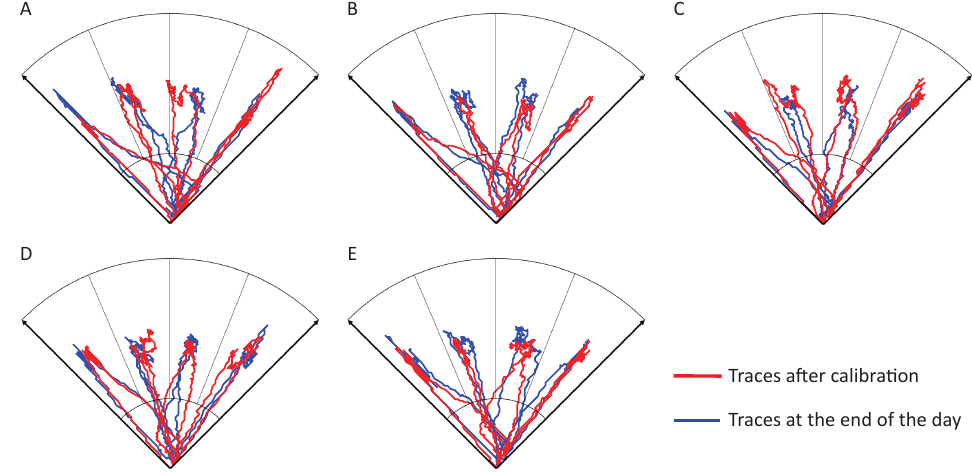
Figure 7. Representative cursor traces on ( A ) Day 1, ( B ) Day 2, ( C ) Day3, ( D ) Day 4, and ( E ) Day